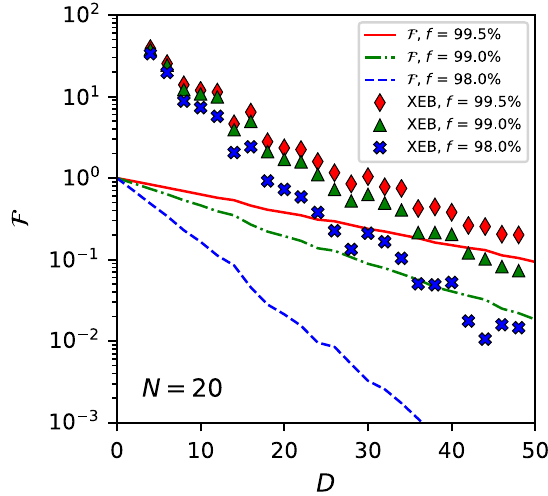
FIG. 8. Comparison between the fidelity F (lines) and the XEB metric B (markers) as a function of depth D . Different colors label different levels of noise on the 2-qubit gates, respectively, f ¼ 99 . 5% (red), f ¼ 99% (green), and f ¼ 98% (blue). The calculations were performed for the 1D random circuit with N ¼ 20 qubits.